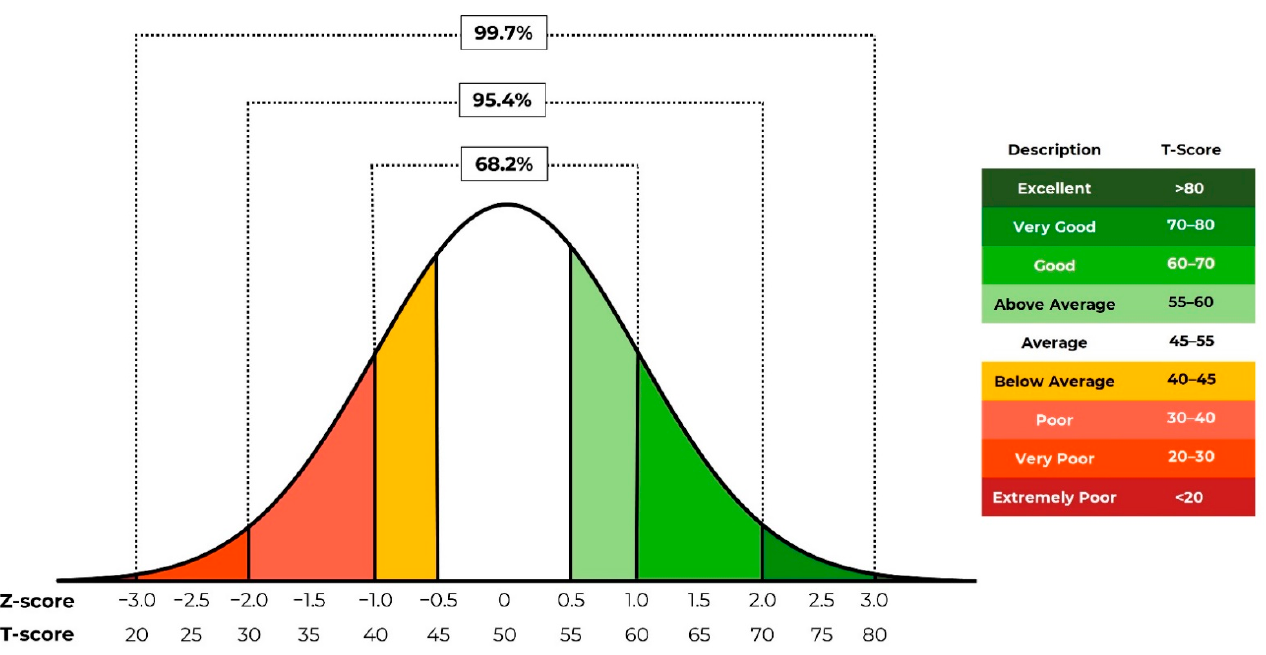
Figure 1. A typical normal data distribution curve with corresponding Z-scores and T-scores and integrated traffic light system example (T-score bands and qualitative descriptions are shown in the key to the right).